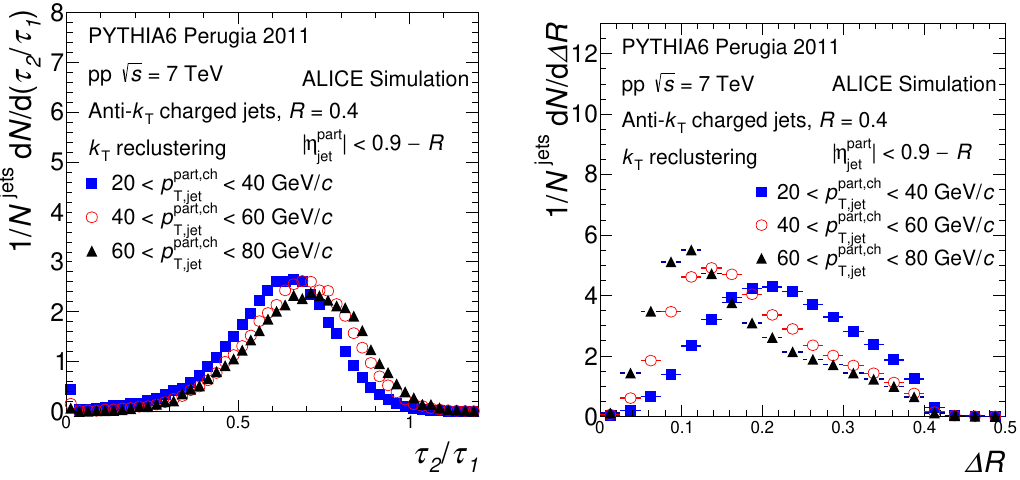
dependence of the τ (left) and ∆ R (right) observables are shown, for the Figure 2 . The p ch 2 /τ 1 T , jet axes obtained using the k reclustering algorithm. These calculations are made using PYTHIA6 T √ Perugia 2011 simulations of pp collisions at s = 7